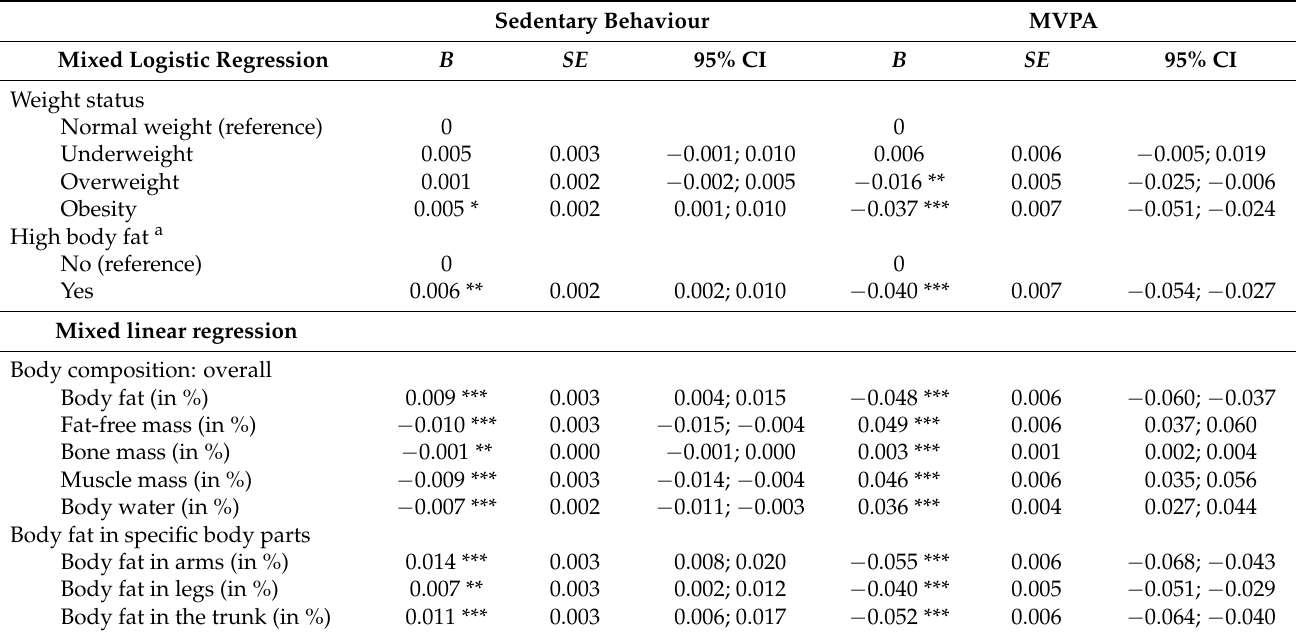
Table 2. Results of mixed multinomial, logistic, and linear regression analyses to predict body composition via sedentary behaviour and moderate-to-vigorous physical